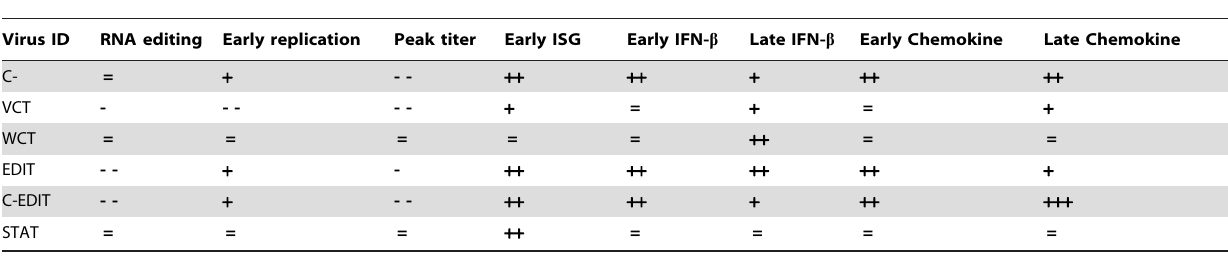
Table 2. Summary of NiV P gene mutation phenotypes in HMVEC-L cells relative to WT.